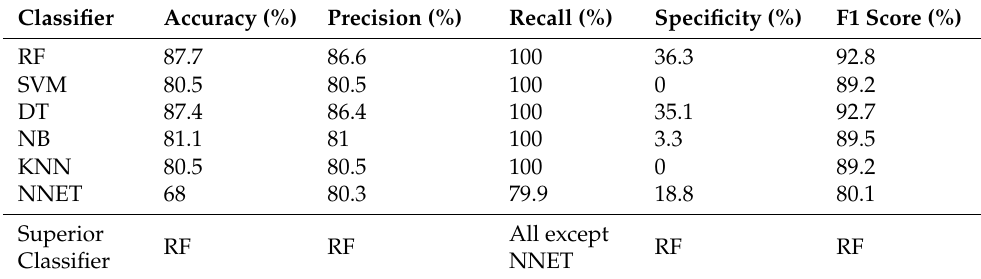
Table 2. Performance comparison of the single-classifier approach on the KNN imputed dataset.